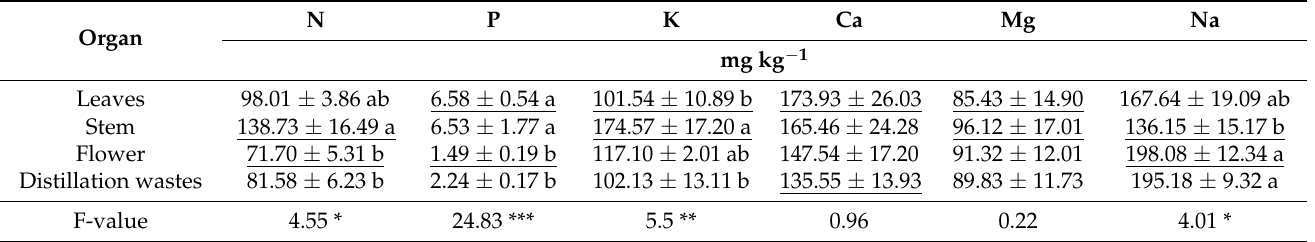
Table 2. Mineral nutrient content (mean ± SD, n = 12) of the different organs of Taif’s rose grown on Al-Shafa highlands in Taif City, Saudi Arabia. Maximum and minimum values are